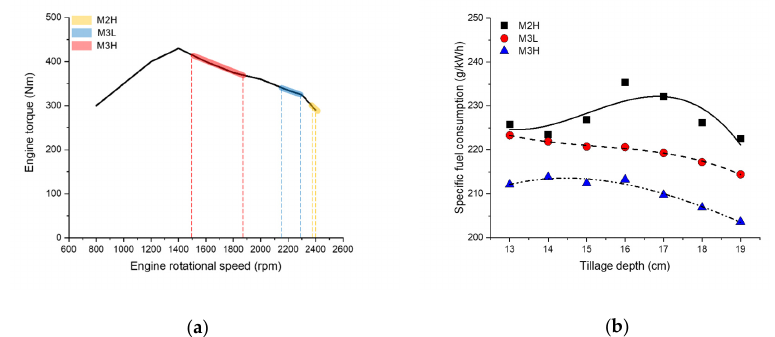
Figure 11. ( a ) Engine performance diagram of an agricultural tractor and ( b ) specific fuel consumption according to tillage depth and gear selections.